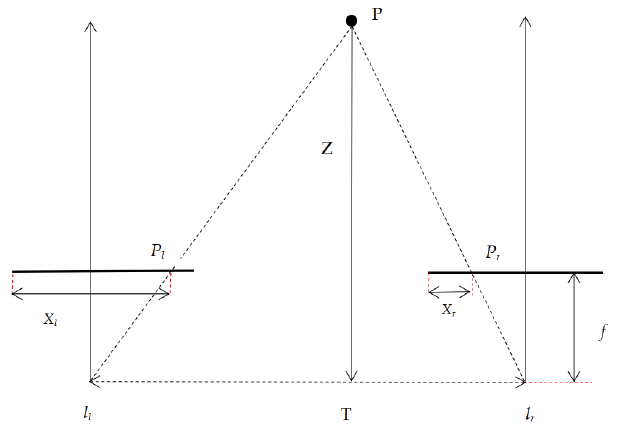
Figure 2. Physical model of binocular vision localization.